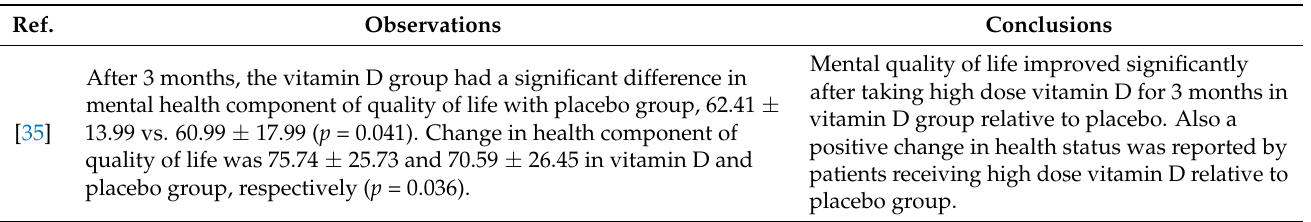
Table 5. The observations and conclusion formulated within the studies of multiple sclerosis (MS) patients included to the systematic